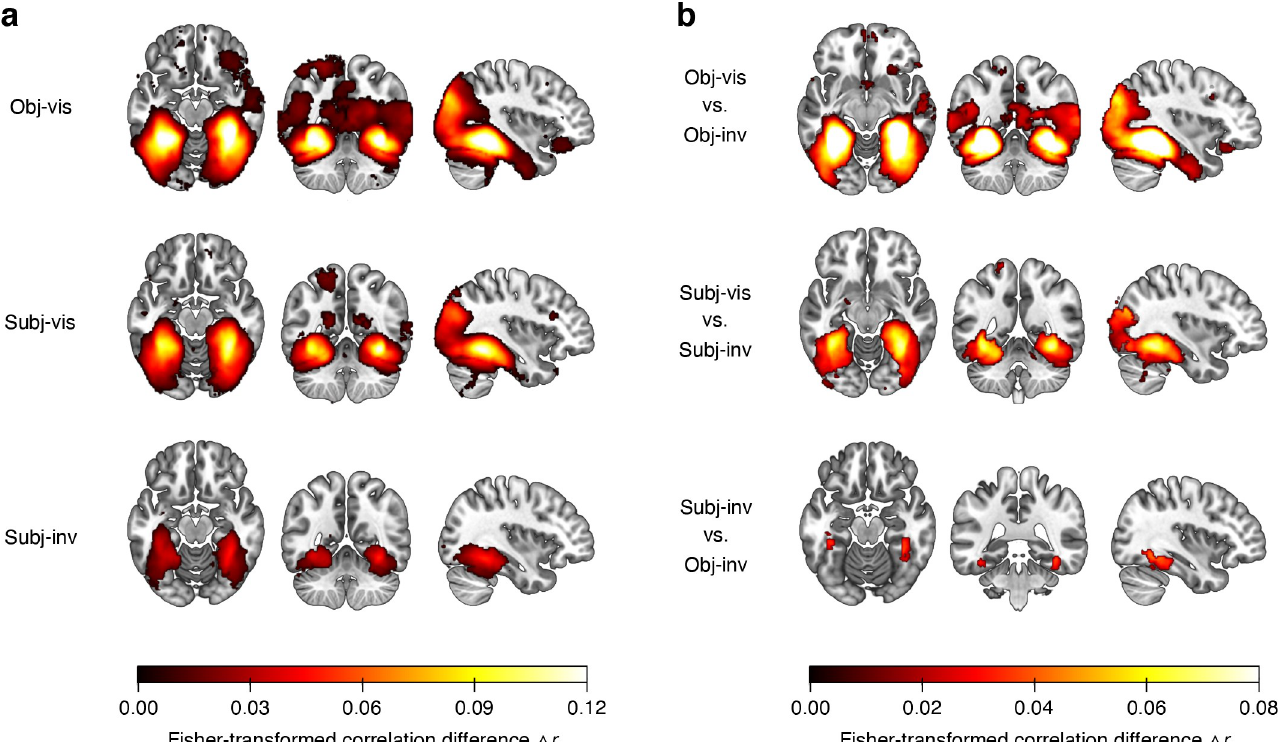
Fig 3. (a) Searchlight results showing clusters with significant category information across the whole brain, separately for the different visibility conditions. Only voxels surviving multiple comparison correction via false discovery estimation [55] ( p < 0.05 FDR corrected) are shown. For the obj-inv condition, no clusters survived this statistical threshold. (b) Searchlight results showing the effect of subjective visibility by comparing the obj-vis to the obj-inv condition, the subj-vis to the subj-inv condition, and the effect of method for establishing invisibility by comparing the subj-inv to the obj-inv condition. Data underlying this figure are available on OSF (https://osf.io/qus5v/). FDR, false discovery rate; obj-inv, objectively invisible; obj-vis, objectively visible; subj-inv, subjectively invisible; subj-vis, subjectively